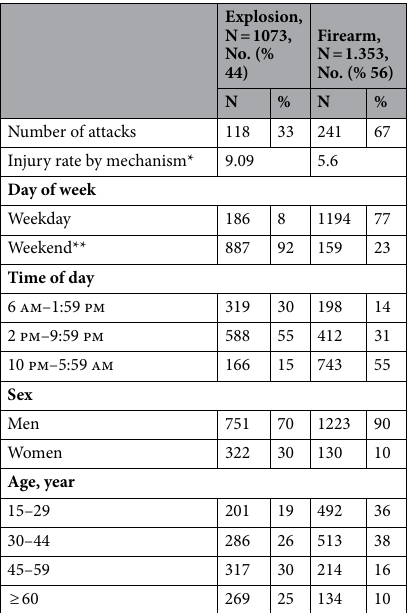
Explosion, N = 1073, No.